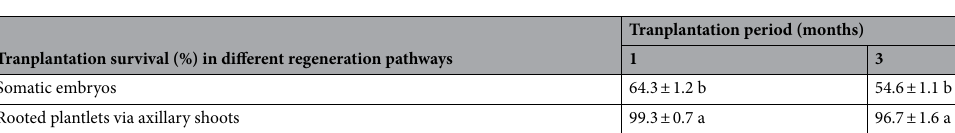
Table 3. Transplantation of somatic embryos and rooting plantlets via axillary shoot of Euryodendron excelsum . Trays were supplemented with peat: sand (1:1, v/v ). Each treatment had 100 SELSs or plantlets. Values represent means ± SD. Different letters within a column indicate significant differences according to Duncan’s multiple range test ( P ≤ 0.05).